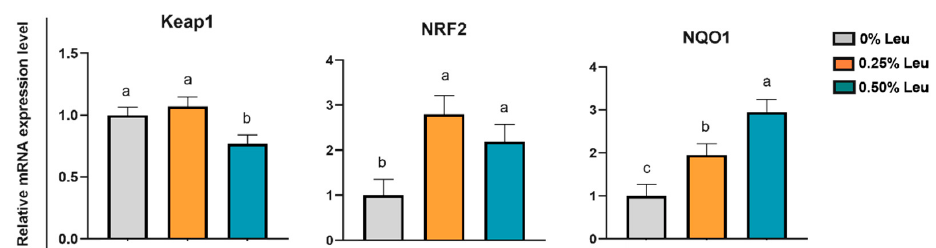
Figure 2. Relative mRNA expression levels of key genes related to antioxidant capacity in liver. Leu: Leucine. a–c Different superscript letters on the same line are significant differences ( p < 0.05).